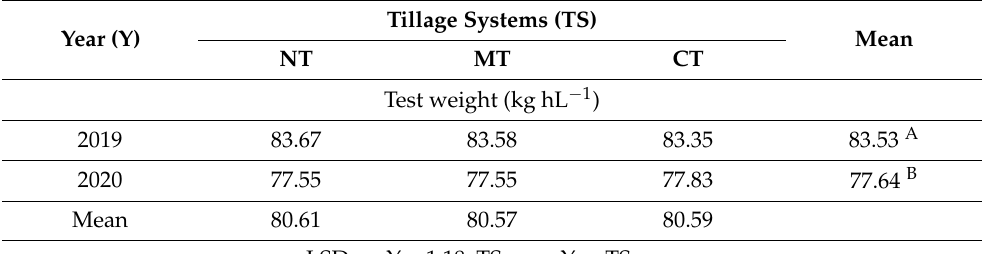
Table 5. Influence of soil tillage systems on the quality parameters during the 2019 and 2020 growing seasons ( p <